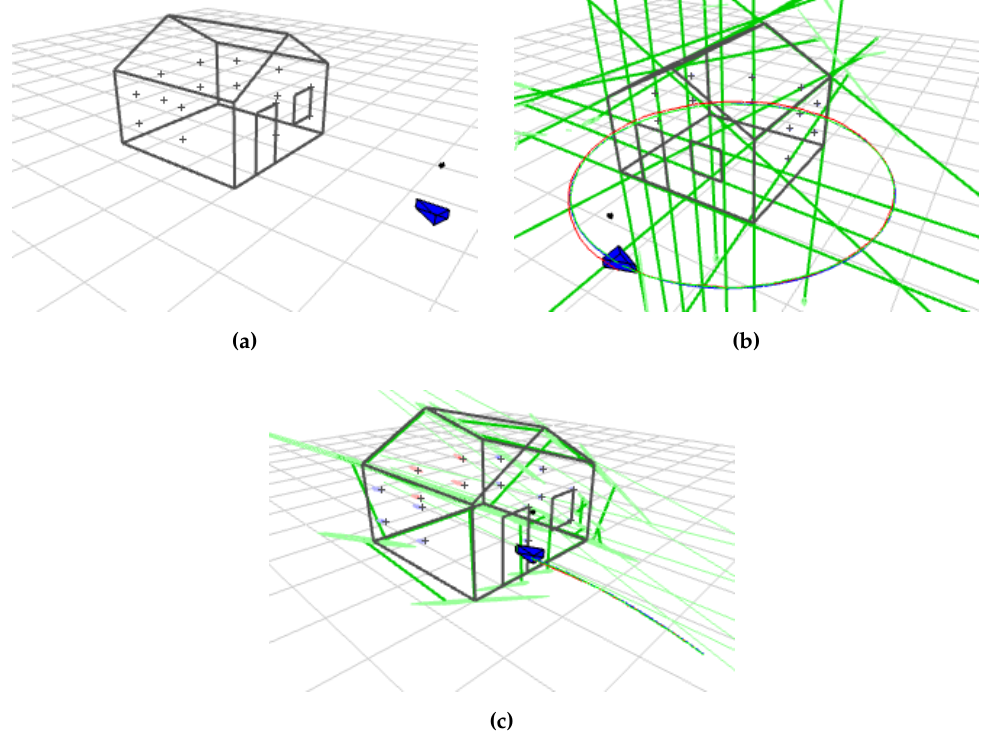
Figure 10. Environment world used for the simulation experiments of heterogeneous point and line SLAM. ( a ) Initial state of the environment world; ( b ) environment after performing circular trajectory with anchored homogeneous point (AHP) + Plücker line (PL) parametrization; ( c ) environment after performing approaching trajectory with AHP + AHPL parametrization.